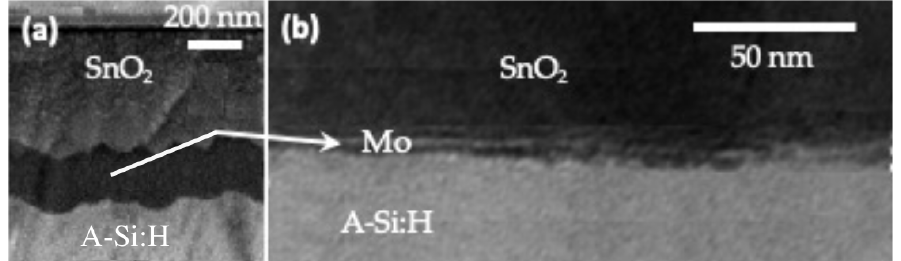
Figure 2. ( a ) Cross-section of a solar cell based on the structure of Figure 1 stack from SEM analysis ( b ) Cross-section of the cell stack from TEM